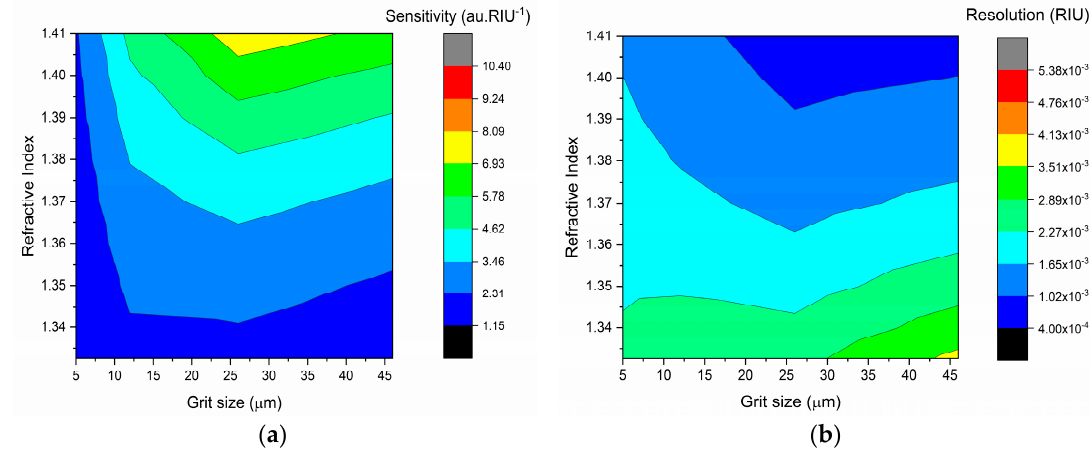
Figure 10. Sensitivity ( a ) and resolution ( b ) of the D-shaped POF sensors.